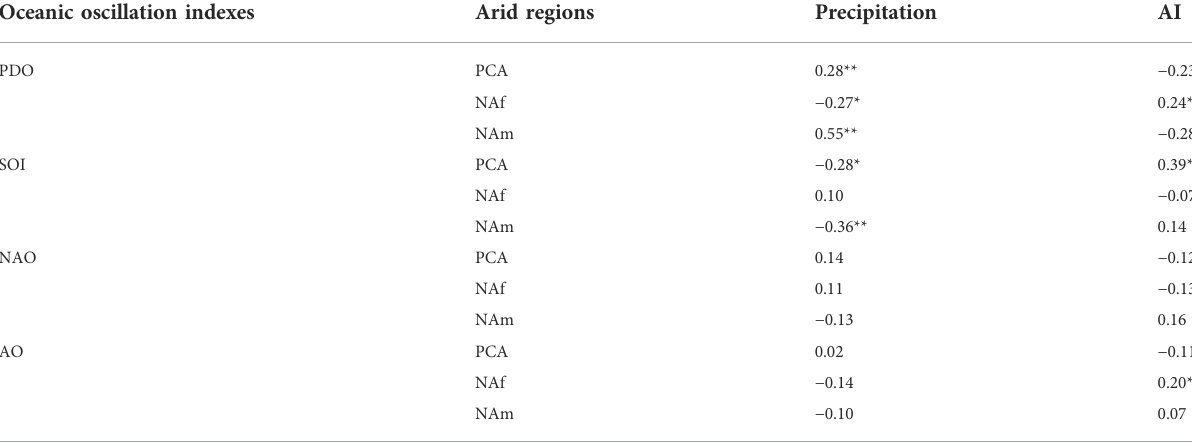
TABLE 3 Correlations of the precipitation and AI with the PDO index, SOI, NAO index and AO index in three arid regions from 1941 to 2020. Oceanic oscillation indexes Arid regions Precipitation AI PDO